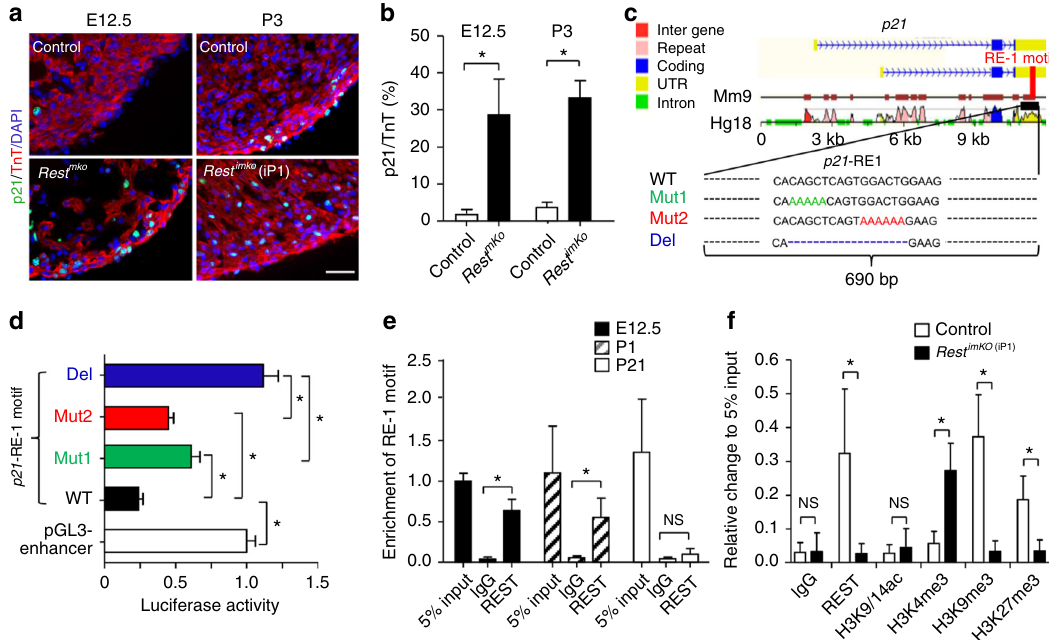
Fig. 3 REST binds p21 to repress its expression. a , b Immunostaining ( n = 4/group) showing upregulated p21 protein level in the Rest deleted E12.5 and P3 hearts. Scale bar = 40 µ m. c Top, Sequence alignment of p21 between mouse and human indicating a conserved RE-1 motif (red vertical line) located at the 3 ′ UTR. Bottom, The p21- RE1 motif and its mutated (Mut) or deleted (Del) counterpart. d Luciferase reporter assays with a 690-bp mouse DNA fragment containing the wild type (WT), mutated, or deleted RE1 motif reveals that the intact p21- RE1 motif is required for repressing the reporter gene transcription in primary cultured P1 mouse cardiomyocytes. e qChIP using REST antibodies indicates enrichment of p21- RE1 motif containing DNA fragments in the ventricles of E12.5 and P1, but not P21. f qChIP with P2 ventricles using the REST and histone mark antibodies showing the REST-dependent histone modi fi cation of the p21- RE1 motif. n = 3/group for d – f , mean ± s.d., * p < 0.05 by one-way ANOVA followed by Tukey ’ s test in d ; unpaired Student ’ s t test in b , e , f . NS no signi fi